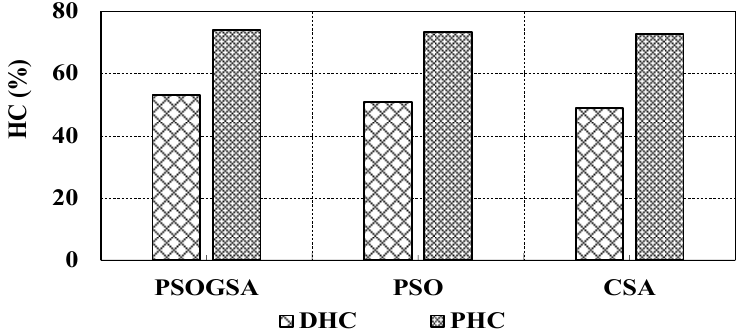
Figure 8. Overall comparison between the DHC and PHC results, achieved by using different design approaches.